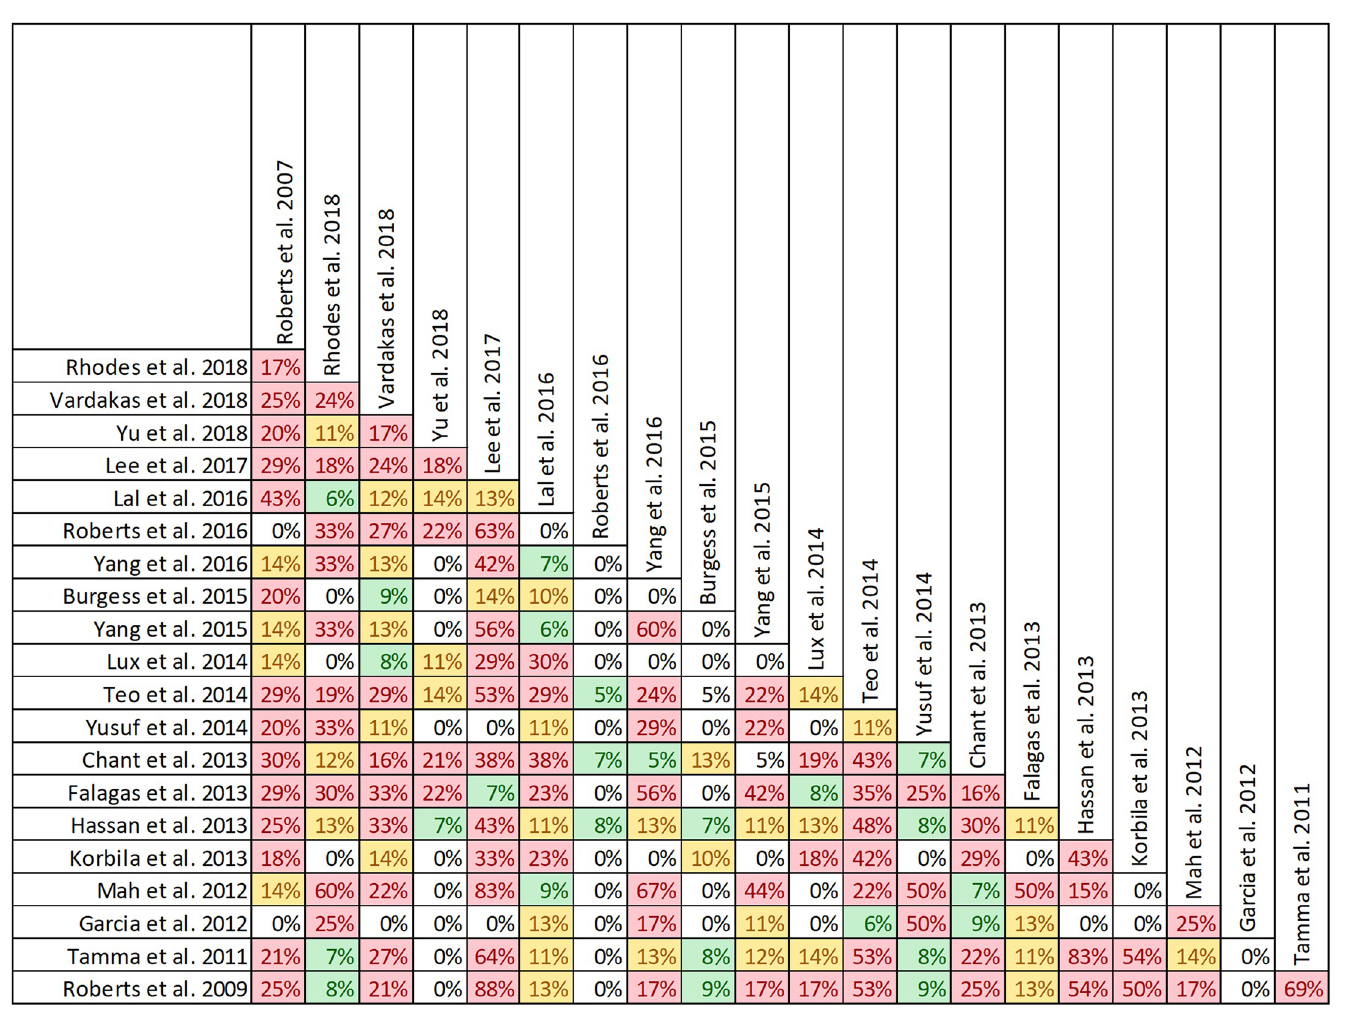
Fig 8. Pairwise CCA of reviews reporting clinical cure of prolonged versus intermittent infusions of beta-lactams. Colors indicate degree of overlap, as calculated with CCA, for visual clarity. White = � 5%, green 5.1–9.9%, yellow 10–14.9%, red � 15%.